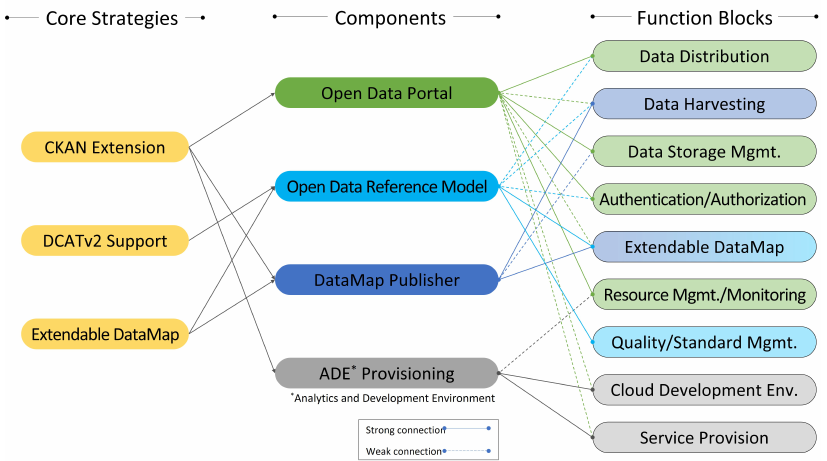
Figure 5. Relationship among SODAS major components and function blocks.